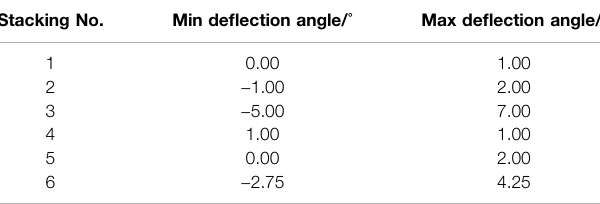
TABLE 4 | De fl ection angle ranges of six stacking sequences with unit ply angle misalignment in each layer at one time. Stacking